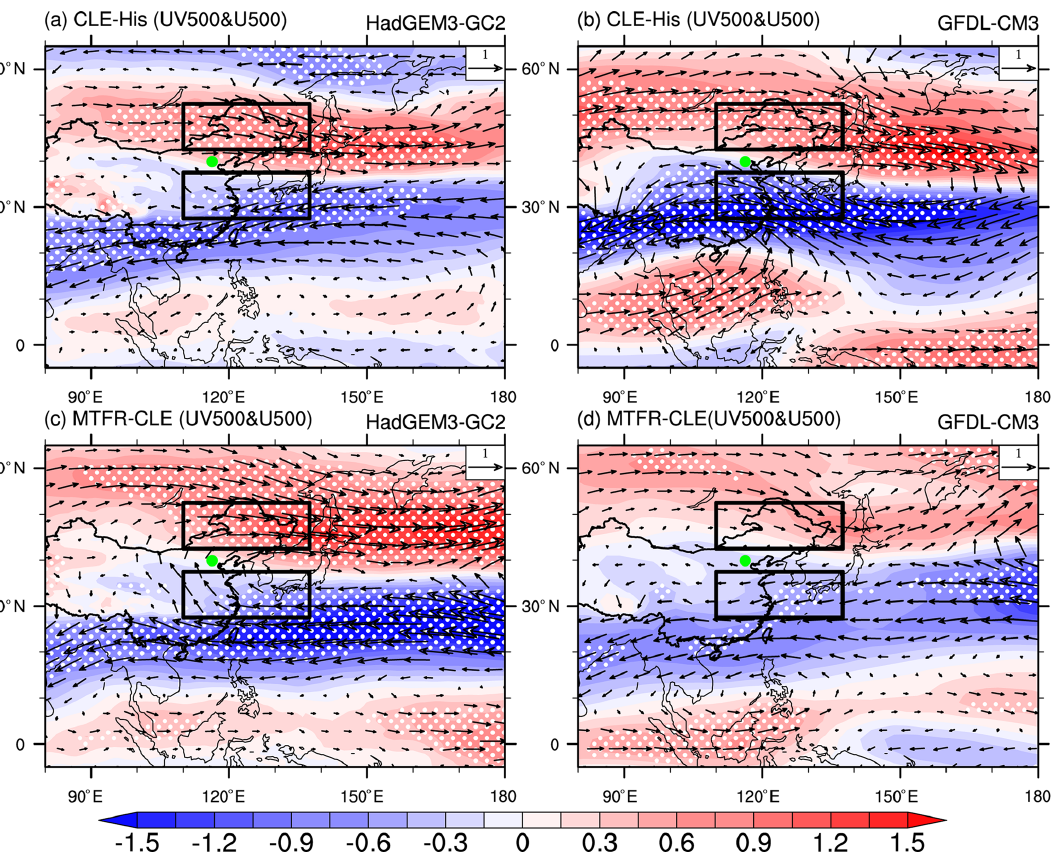
Figure 7. Same as Fig. 6 but for the difference in 500hPa winds (vector, ms − 1 ) and 500hPa zonal component (shading, ms − 1 ). The black boxes indicate the regions used in the calculation of